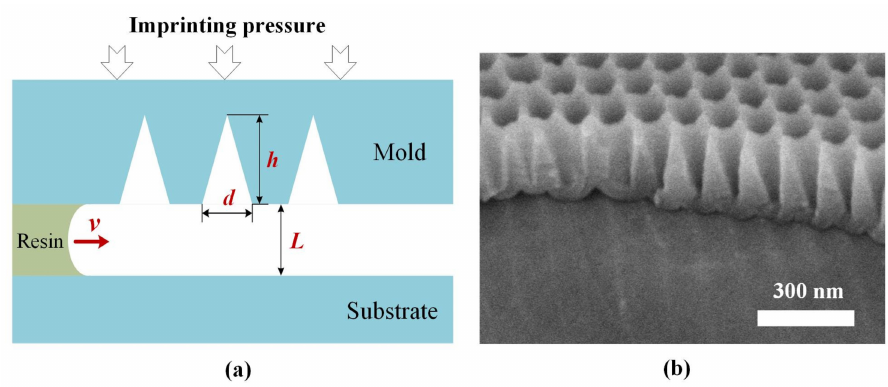
Figure 1. The UV-NIL of moth-eye nanostructure ( a ) schematic diagram ( b ) imprinting mold. Figure 2 presented the viscosity property at different temperatures, which was ob-